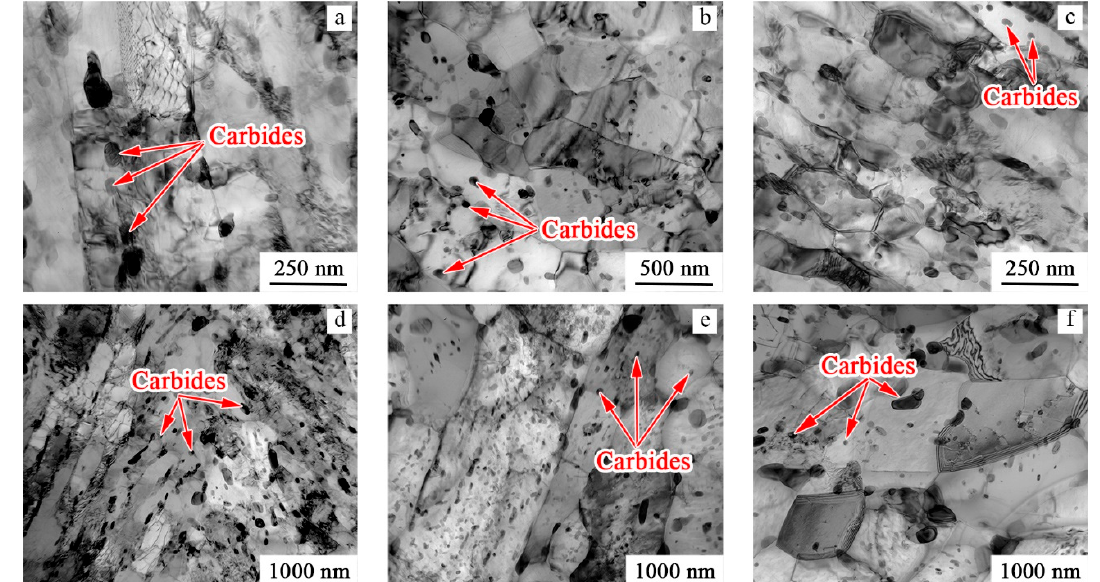
Figure 8. TEM photographs of fine structure after compression at 600 ◦ C ( a–c ) and 700 ◦ C ( d–f ) with strain rate of 1.3 · 10 − 3 s − 1 to di ff erent strain degrees ( ε ): 0 ( a , d ), 0.3 ( b , c ) and 1.15 ( e , f ).